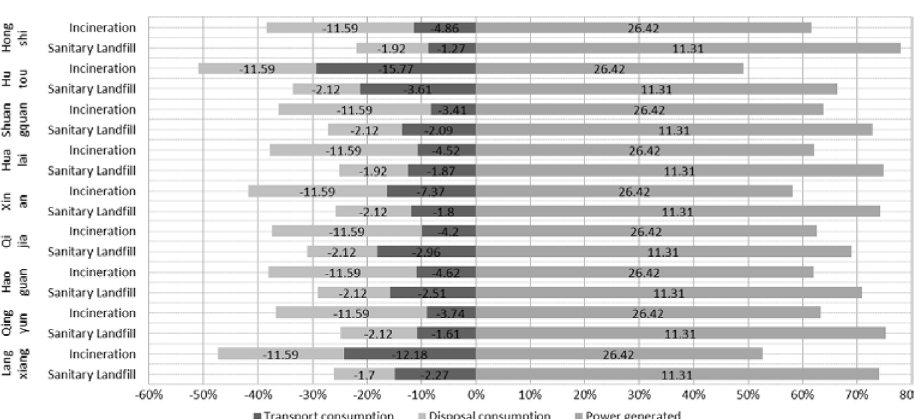
Fig. 1. Energy consumption and recycling for per-ton garbage disposal (stand coal